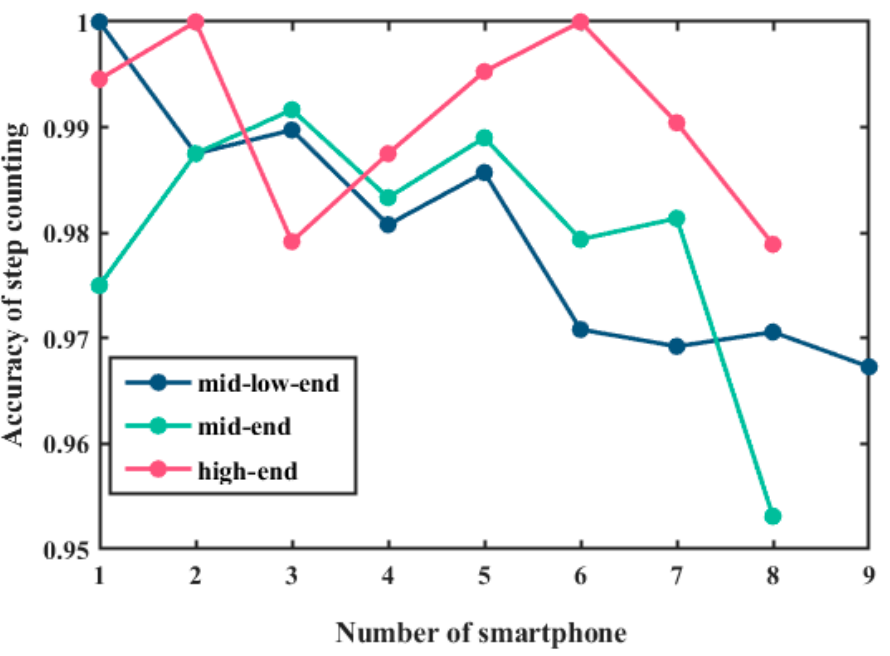
Figure 16. Step counting accuracy rate of smartphones with different prices in unconstrained state.